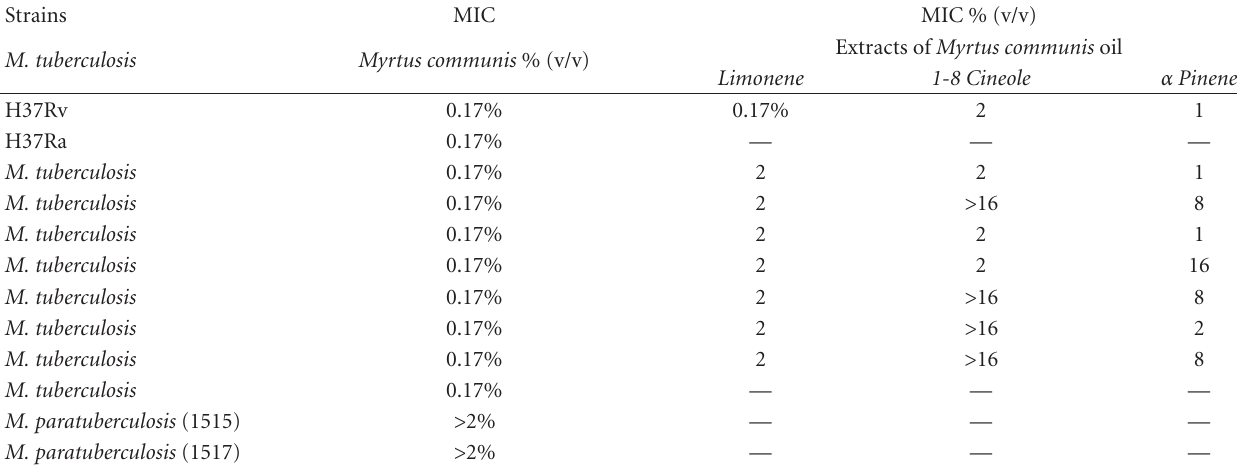
Table 2: Activity of Myrtus communis and single compound against Mycobacterium tuberculosis strains.